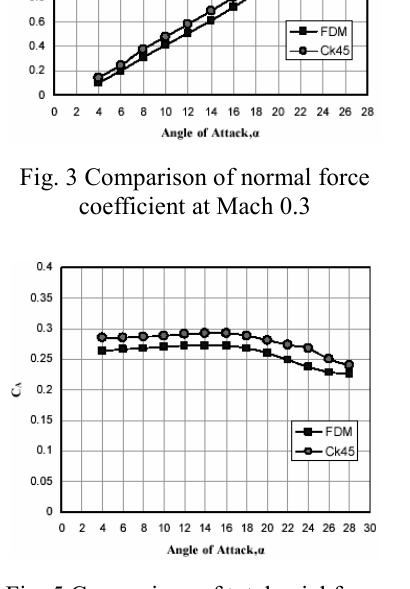
Fig. 5 Comparison of total axial force coefficient at Mach 0.3